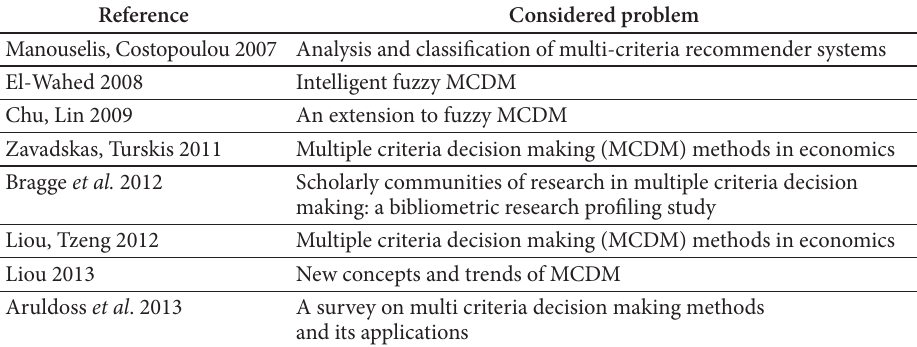
Table 3. General reviews on MCDM in articles of scientific